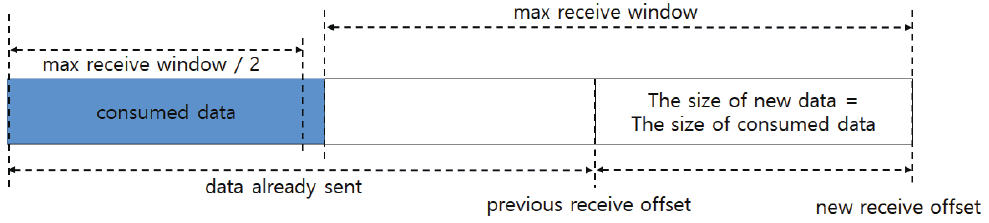
Figure 5. Increased receive offset by receiving MAX_STREAM_DATA frame.